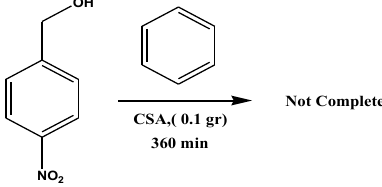
Figure 5. The mechanism of preparation of supported sulfonic acid on silica gel. 1 mM of various alcohols with 3 ml of toluene was provided. Methyl substituted is electron donor and activator of benzene ring in electrophilic substitution reaction. It is expected that the reaction rate increases. The results is given at Table 1. The reaction rate of toluene is more than benzene (Figure